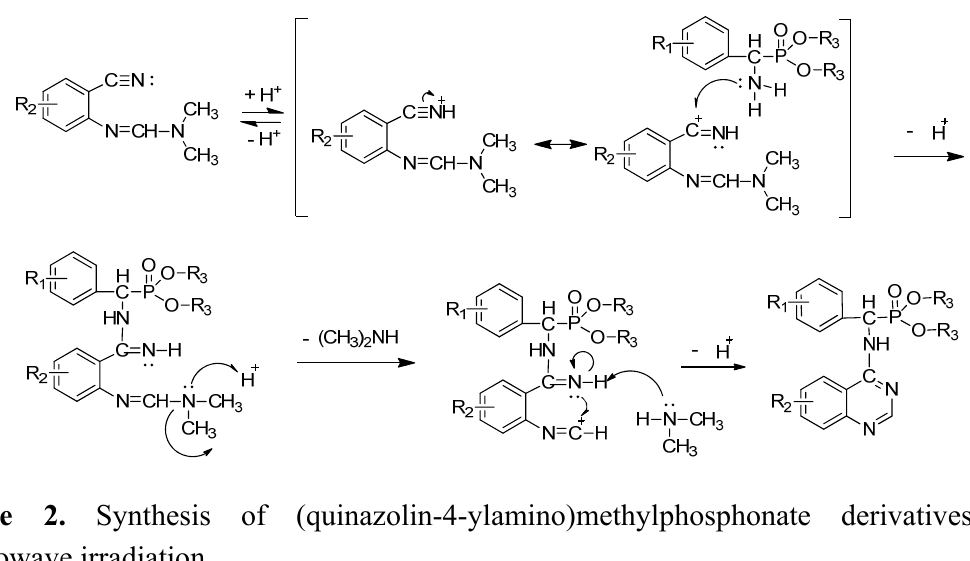
2. Synthesis of (quinazolin-4-ylamino)methylphosphonate derivatives via microwave